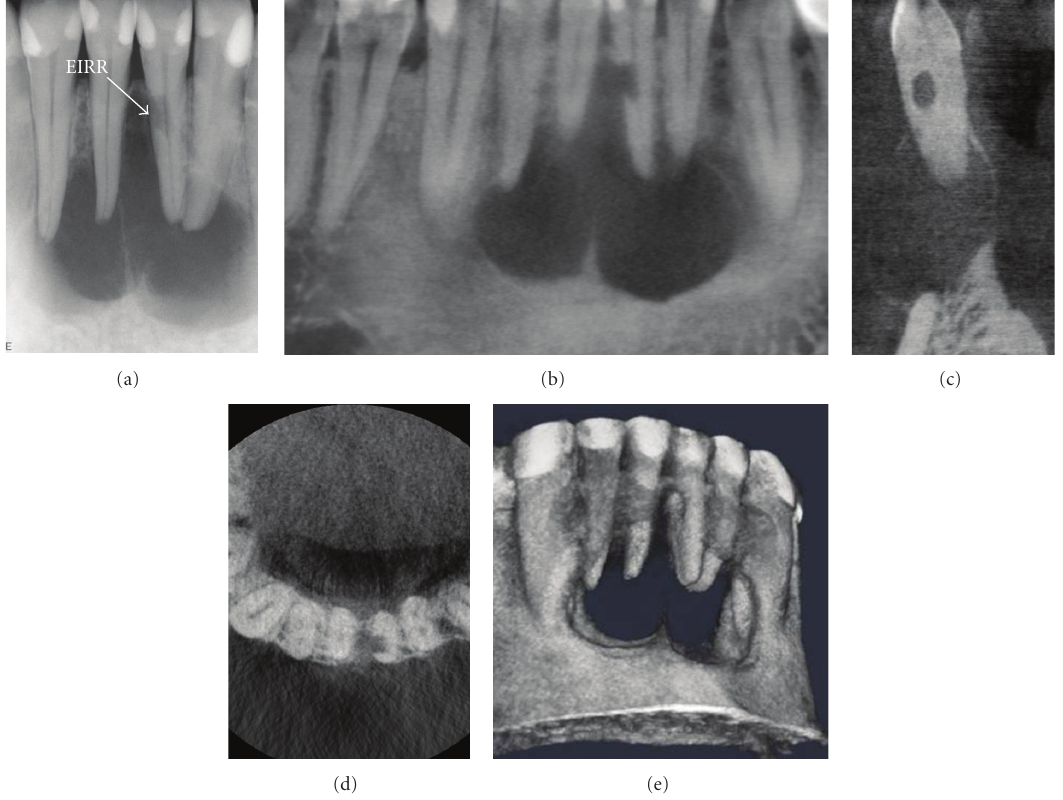
Figure 3: After su ff ering a traumatic blow from a soccer ball six years earlier, a 28-year-old male presented with a soft, convex-shaped indurated buccal and lingual swelling in the mandibular symphyseal region. A periapical image (a) showed a large, multilocular lesion. External inflammatory root resorption (EIRR) was noted on the mandibular left lateral incisor. All four mandibular anterior teeth tested nonvital. CBCT images ((b) curved planar, (c) cross-sectional, (d) axial, (e) 3D reconstruction) showed that the resorptive lesion was extended from the root canal space to the periodontal membrane, necessitating repair or extraction; no exploratory procedure was necessary to determine the extent of the